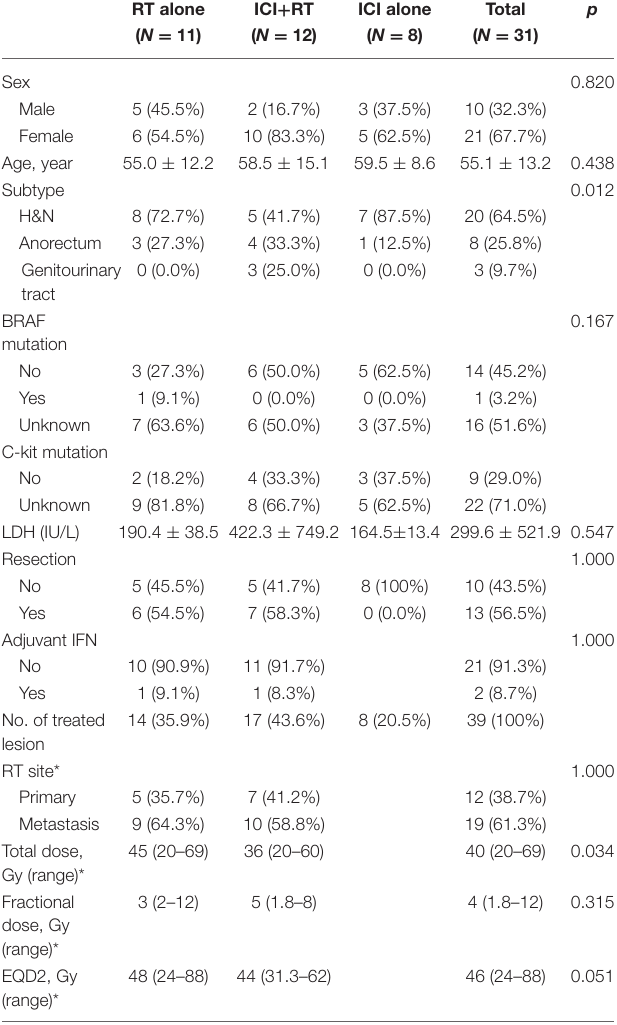
TABLE 1 | Patient